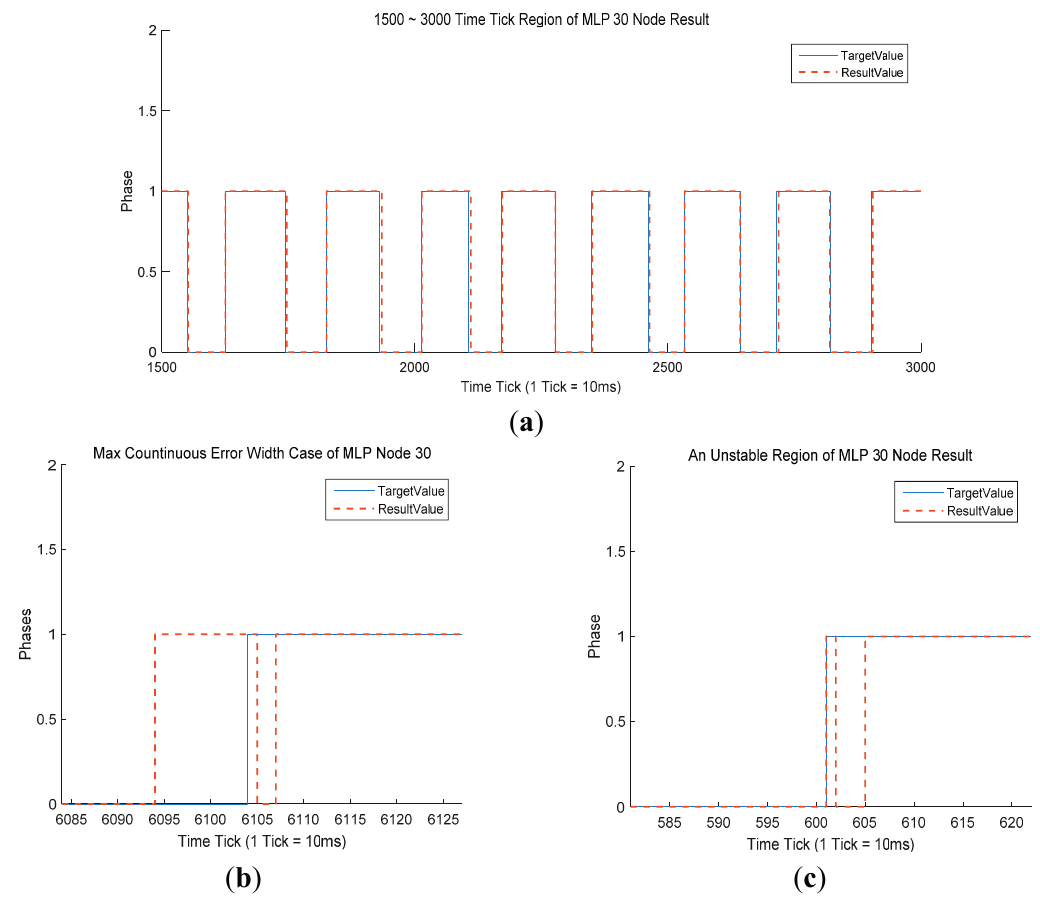
Figure 5. ( a ) Comparison of results and target value for the MPL with 30 nodes over frames 1500–3000. The blue line denotes the target value acquired by the force plates. The orange dotted line denotes the classification result of the MLP with a 30-node classifier, the best MLP-based classifier; ( b ) Max continuous error width for the MLP with 30 nodes; ( c ) An unstable region for the MLP with 30